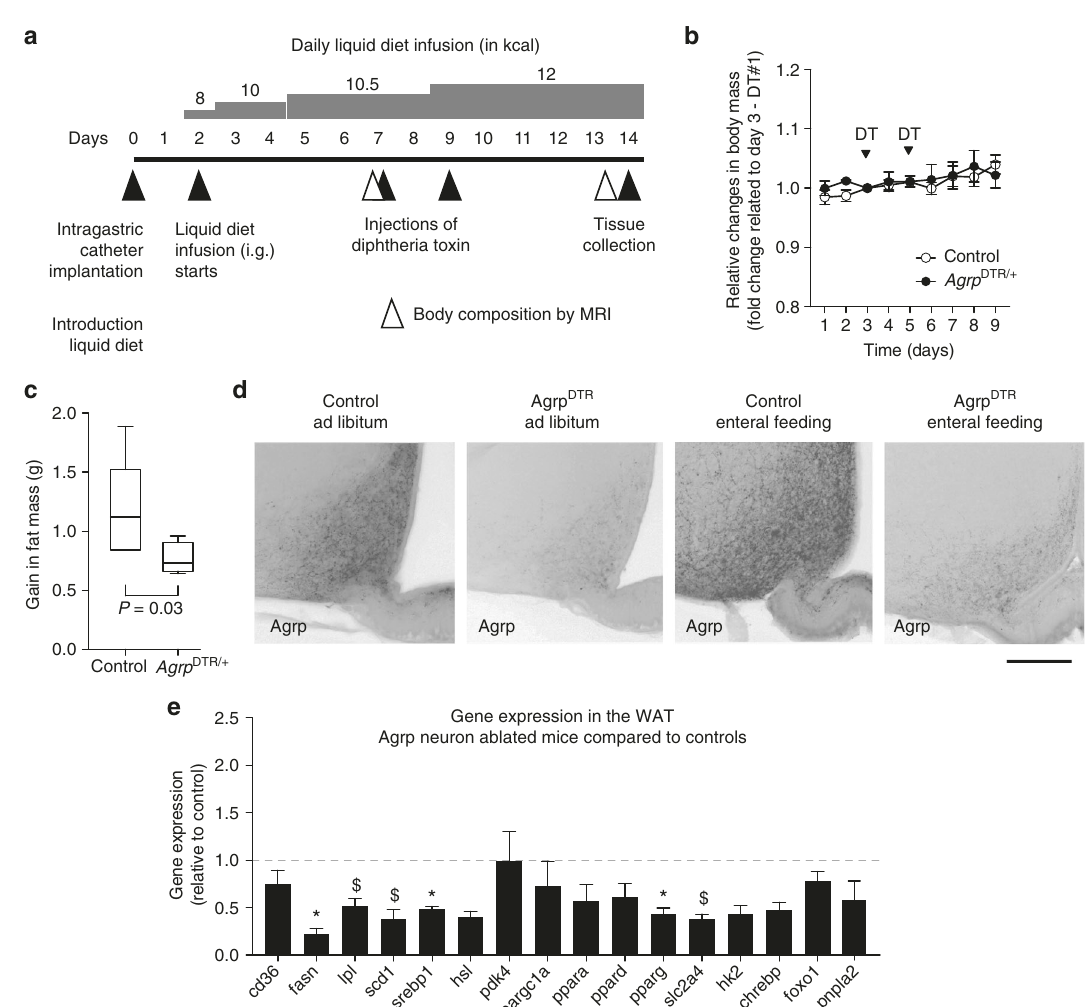
Fig. 7 Agrp neuron ablation impairs fat gain during positive energy balance. a Model of positive energy balance by intragastric delivery of liquid diet in mice concomitant with ablation of Agrp neurons. b Relative changes in body weight represented by fold-changes related to day 3 of the protocol — when animals received the fi rst injection of diphtheria toxin. c Gain in fat mass. d Immunohistochemistry for AGRP. e Gene expression in the WAT. Data are normalized to control levels (dashed line). Statistical analysis was performed using Student ’ s t -test. * P < 0.05, $ P < 0.10 (non-signi fi cant). Bars and symbols indicate mean ± SEM. N = 4 animals per group. Boxes indicate median ± 25/75 quartiles ± min/max values. P values are provided in the fi gures. Scale bar = 50 µ